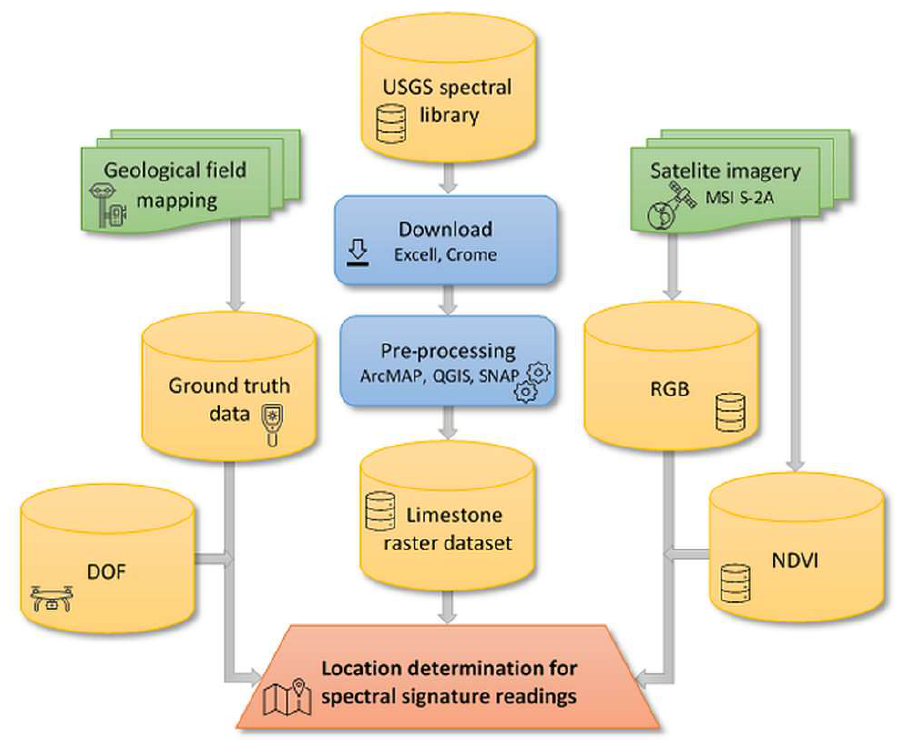
Figure 3. Geological mapping with DOF analysis, USGS data processing, RGB and NDVI flowchart.